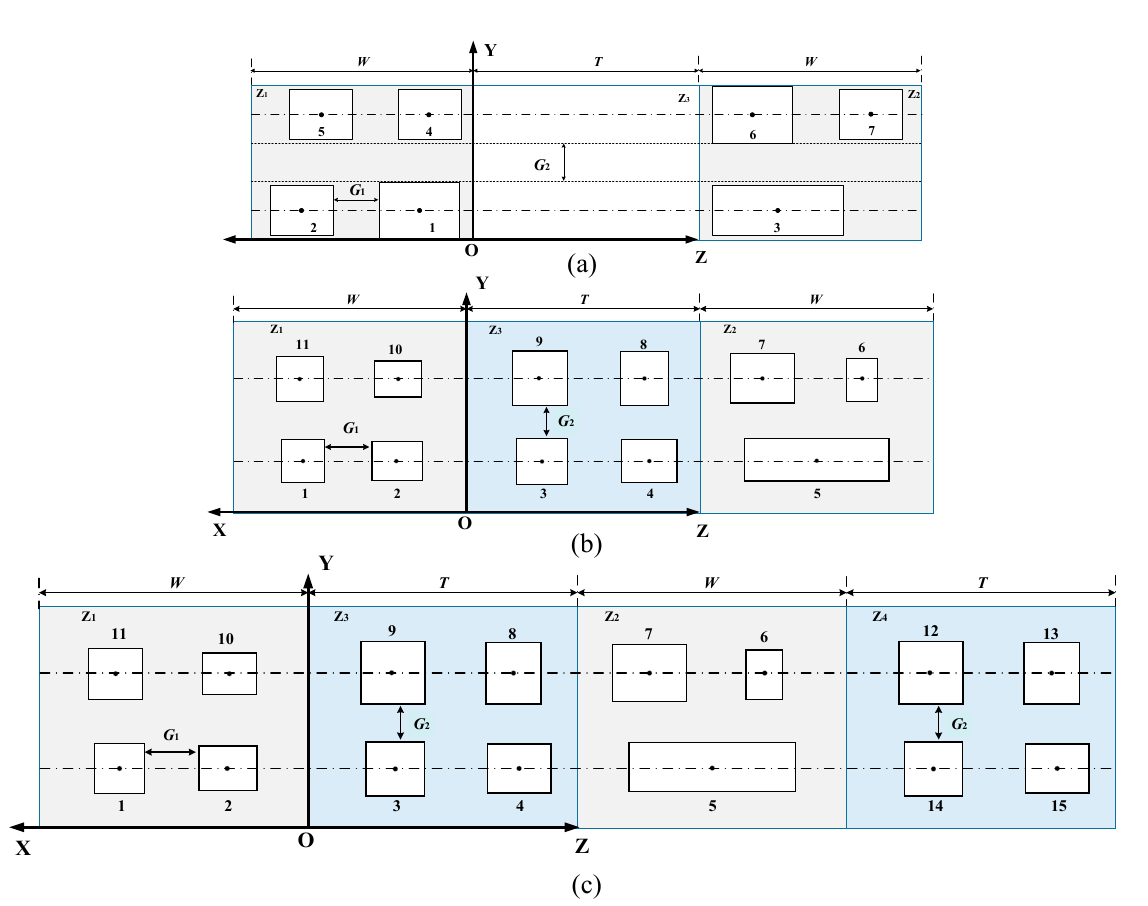
Figure 5. Plane diagram of single manufacturing cell. ( a )—linear plane cell; ( b )—U-shaped plane cell; ( c )—circular plane cell.